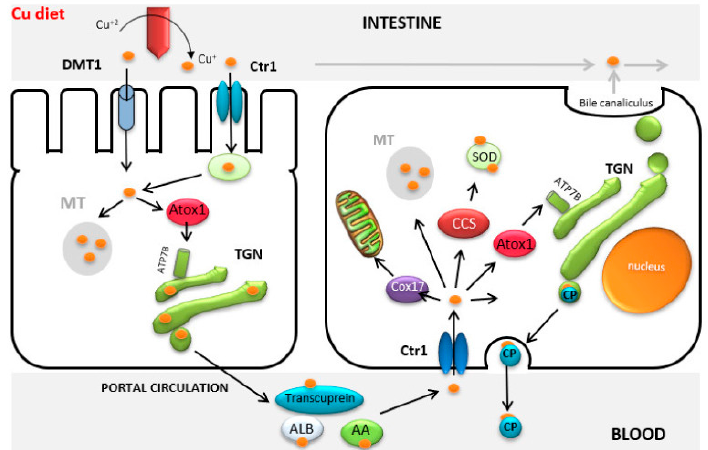
Figure 2. Copper transport. Ctr1: Copper specific transporter; DMT1: Divalent Metal Transporter 1; MT: Metallothionein; TGN: Trans Golgi Network; Cox17 and Atox1: Copper chaperone proteins; SOD: Superoxide dismutase; CP: Ceruloplasmin; CCS: Cytochrome c oxidase; ATP7B: Copper-transporting P-type ATPase (adapted from [76]).